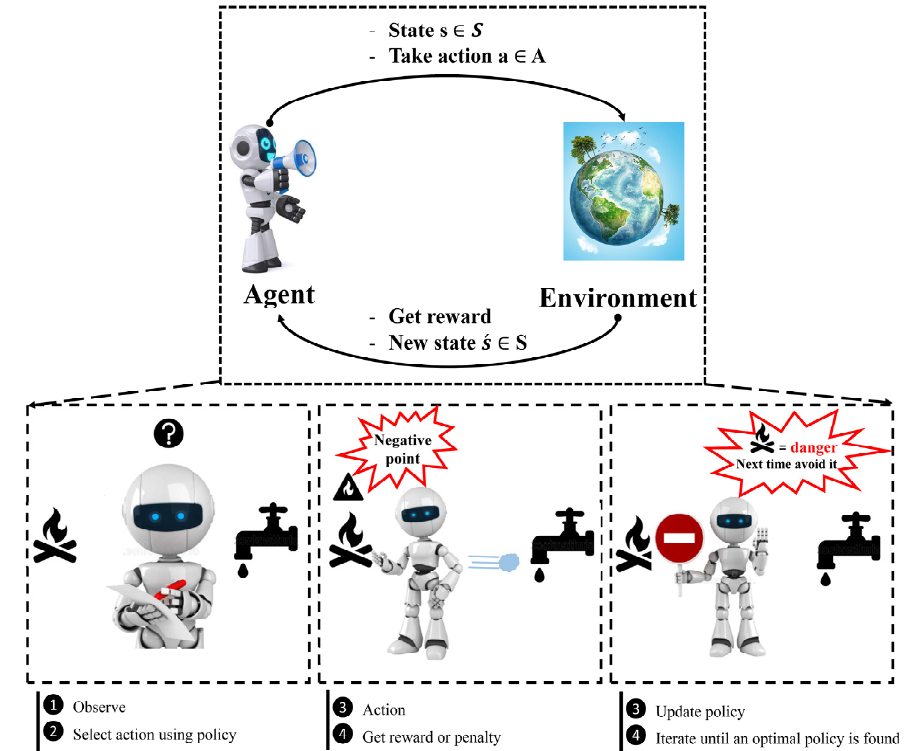
Figure 5. Concept of reinforcement learning